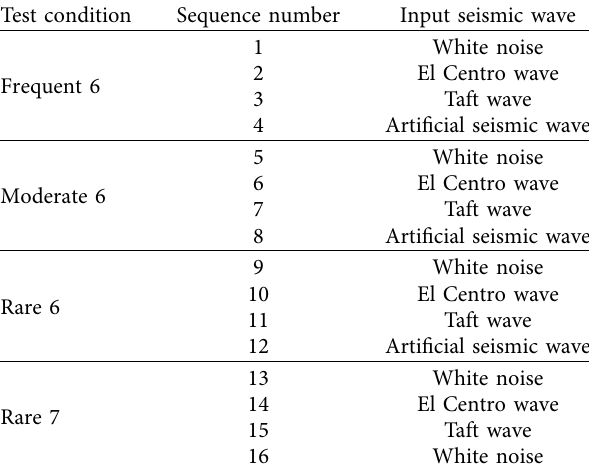
Table 6: Sequence of the shaking table test.